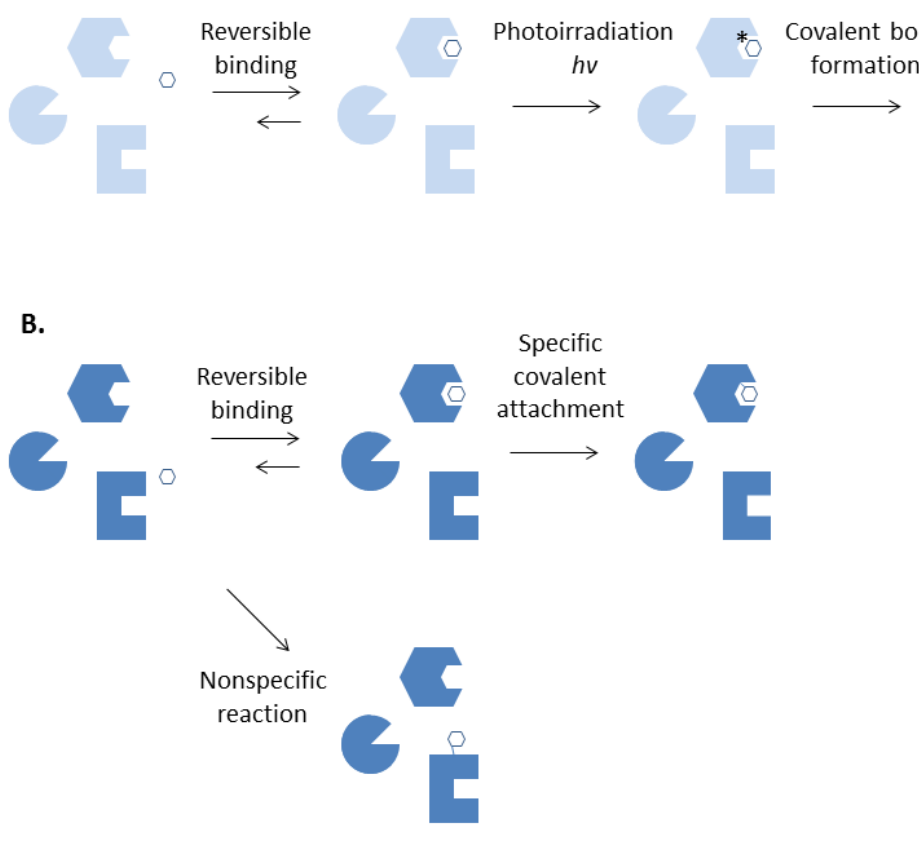
Figure 1. Photoaffinity labeling ( A ) and chemical affinity labeling ( B